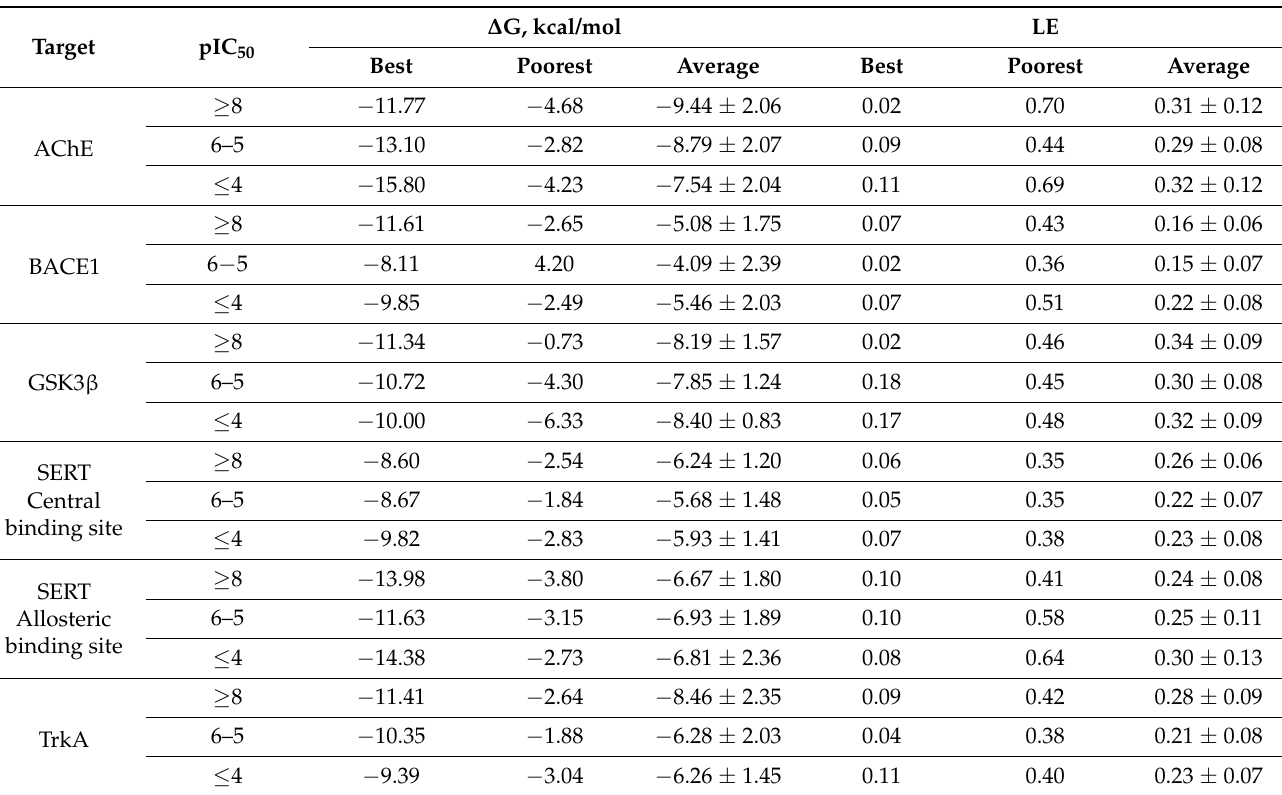
Table 6. The best (lowest binding energy), poorest (highest binding energy) and average values of calculated Glide XP binding energies ( ∆ G, kcal/mol) and ligand efficiencies (LE). The average values of binding energies and LEs are presented as mean ±